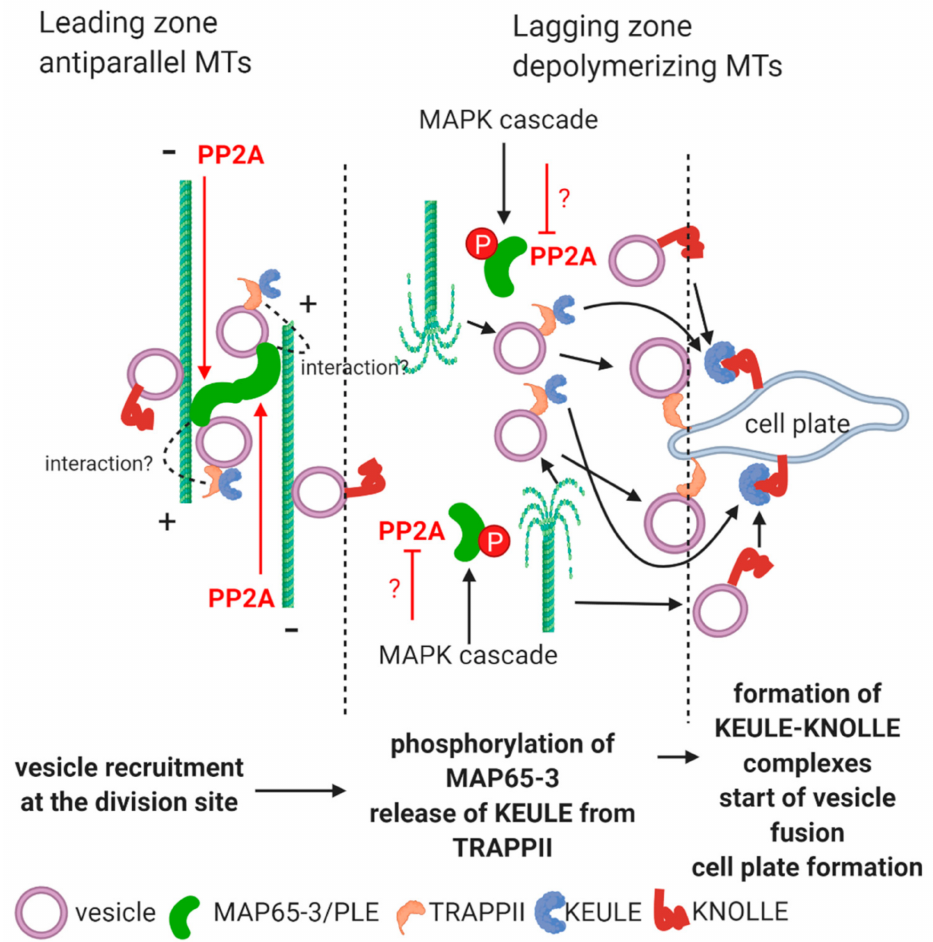
Figure 1. Confirmed and proposed roles of PP2A in vesicle traffic at the formation of the cell plate. For simplifying reasons, the kinesin motors that bind and deliver vesicles along phragmoplast MTs are not shown here. In the leading zone of phragmoplast, MAPK cascade-mediated phosphorylation of MAP65-3/PLE is not functional, while presumably a PP2A complex is dephosphorylating this MAP. As a consequence, it can cross-link antiparallel MTs, while it binds TRAPPII-containing vesicles that in turn, assure the KEULE-MT connection. MAP65-3 is phosphorylated via a MAPK cascade at the lagging zone, while PP2A is possibly inhibited. Thus, MAP65-3 detaches from MTs that will be destabilized as a consequence. This will release TRAPPII/KEULE containing vesicles to the site of cell plate formation and KEULE can interact with KNOLLE, allowing the t-SNARE function of the latter. This triggers vesicle fusion. Confirmed or possible pathways involving PP2A are shown in red. Question marks indicate probable, yet hypothetical events. Figure was constructed with the aid of